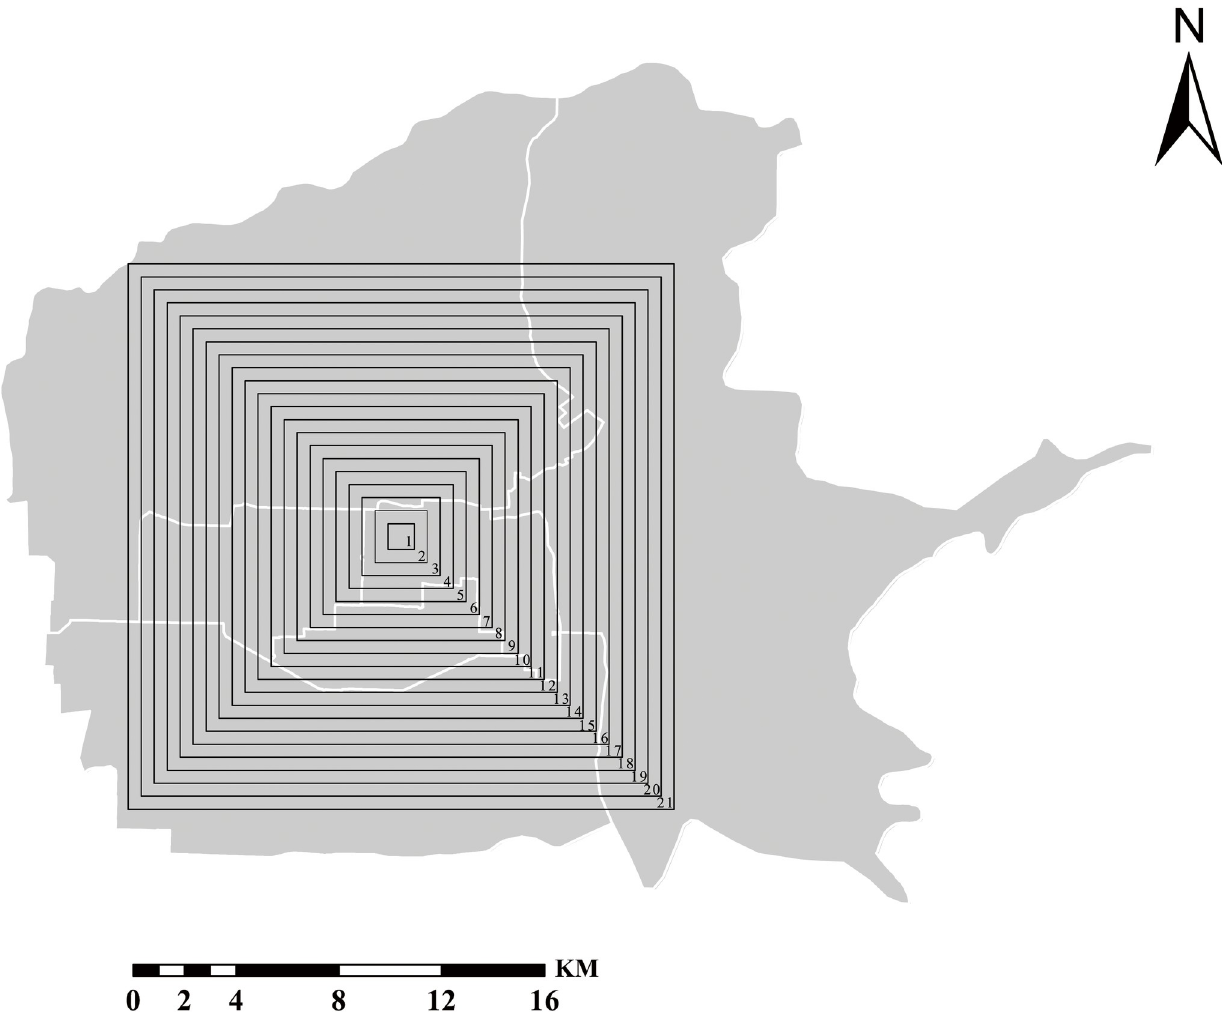
Fig 4. Setting of extent variation. The map images are from the National Catalogue service for Geographic Information: http://www.ngcc.cn/.